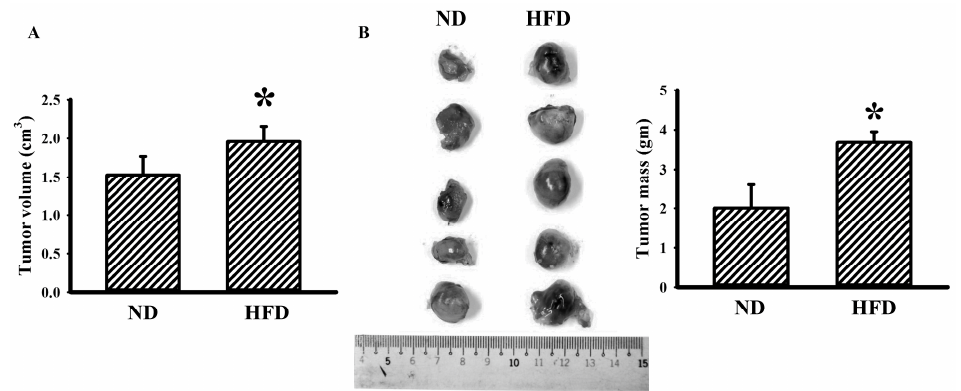
Figure 2. Obesity promoted tumor growth. LLC cells (LLC) were implanted into the lean (ND) and obese (HFD) mice and grew for 2 weeks. The tumor volume ( A ) and tumor mass ( B ) were weighed and analyzed. The resected tumors are shown ( B ). * p < 0.05 vs. ND (n = 5 per group).